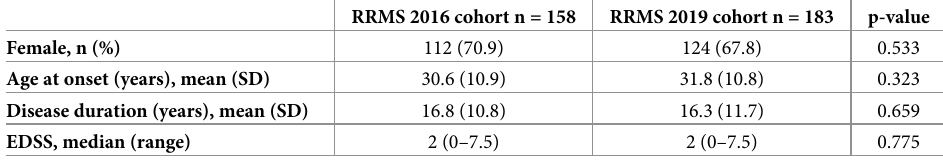
Table 1. Baseline characteristics of RRMS from the 2016 and 2019 cohorts.